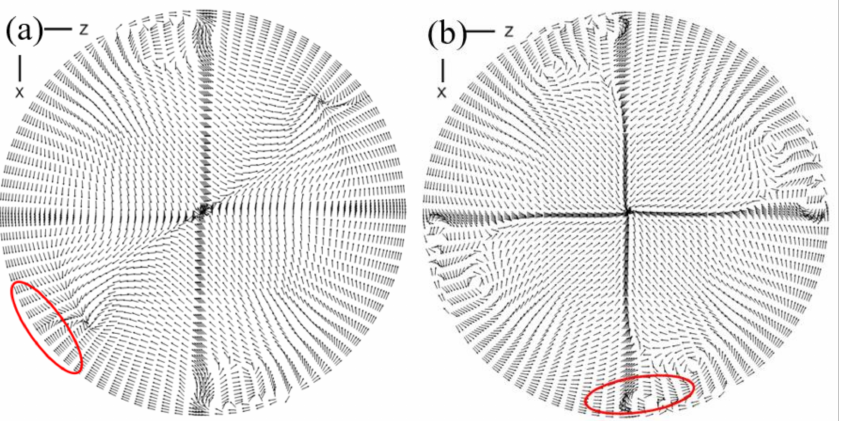
Figure 14. Velocity profiles in cross section at 1000 mm of model ladle with different number of side plug: ( a ) dual side plugs; ( b ) four side